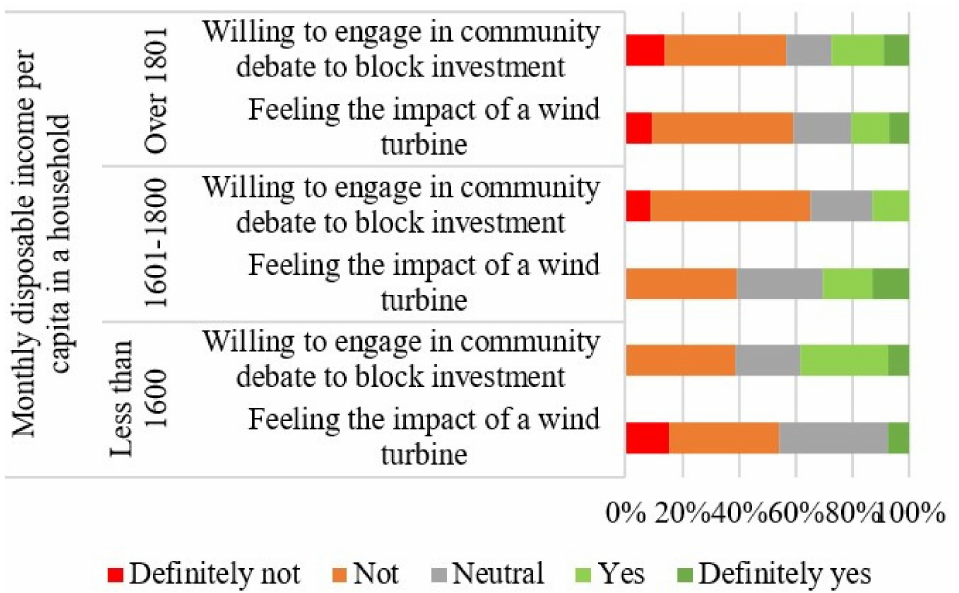
Figure 10. Willingness to participate in social debate to block the development depending on the monthly disposable income per capita in a household (%). Source: based on own